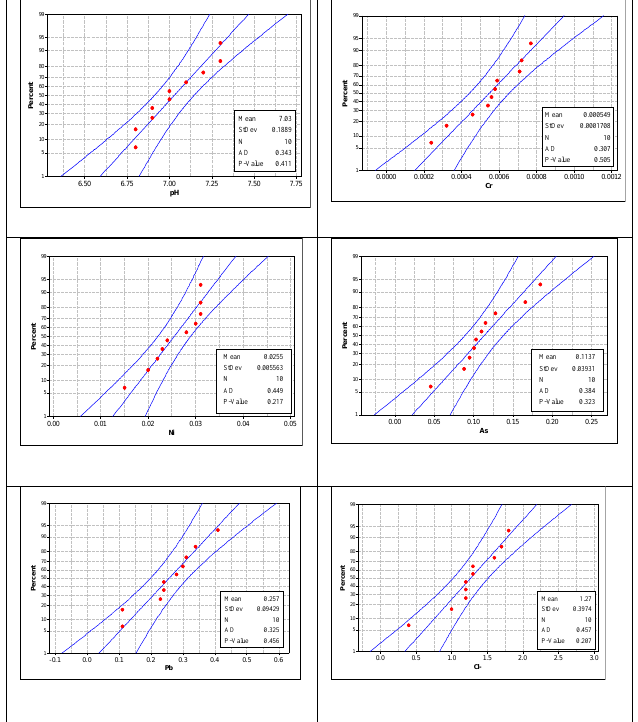
Figure 3: Probability plot of parameters performed at 95% Confidence Level Considering the metal concentrations, Pb recorded the highest mean value of 0.257 mg/kg whiles Cr had the least (0.00055 mg/kg). As and Pb concentrations in water were beyond 1° MCL points of 0.015 mg/l and 0.020 mg/l respectively whereas, concentrations of Cr and Ni were below 1° MCL points of 0.1 mg/l and 0.005 mg/l. The metal ratio (MR) of 0.14 for Cr specifies low water pollution, whiles MR for Ni, As, and Pb were 8.66, 14.14, and 68.57 respectively; indicating very high contamination. However, among the numerous influencing factors, pH is one of the main